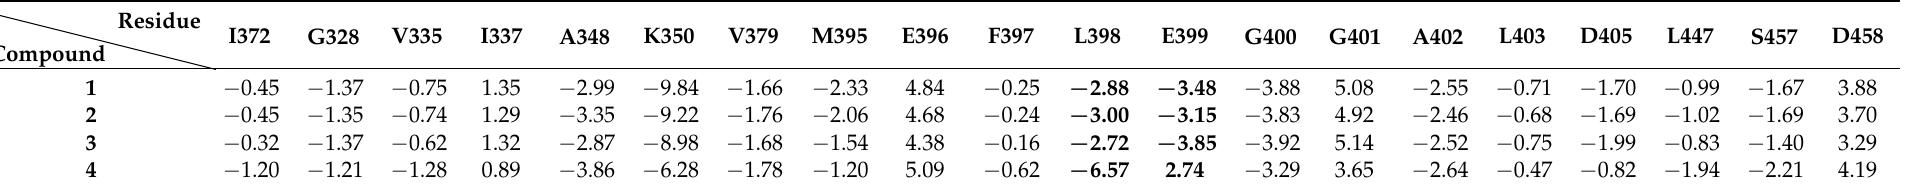
Table 2. Pair interaction energies (E int ) calculated at the FMO-DFTB3/3OB-3-1 level. The pair interaction energies (E int ) of the hinge regions, L398 and E399, are shown in bold.